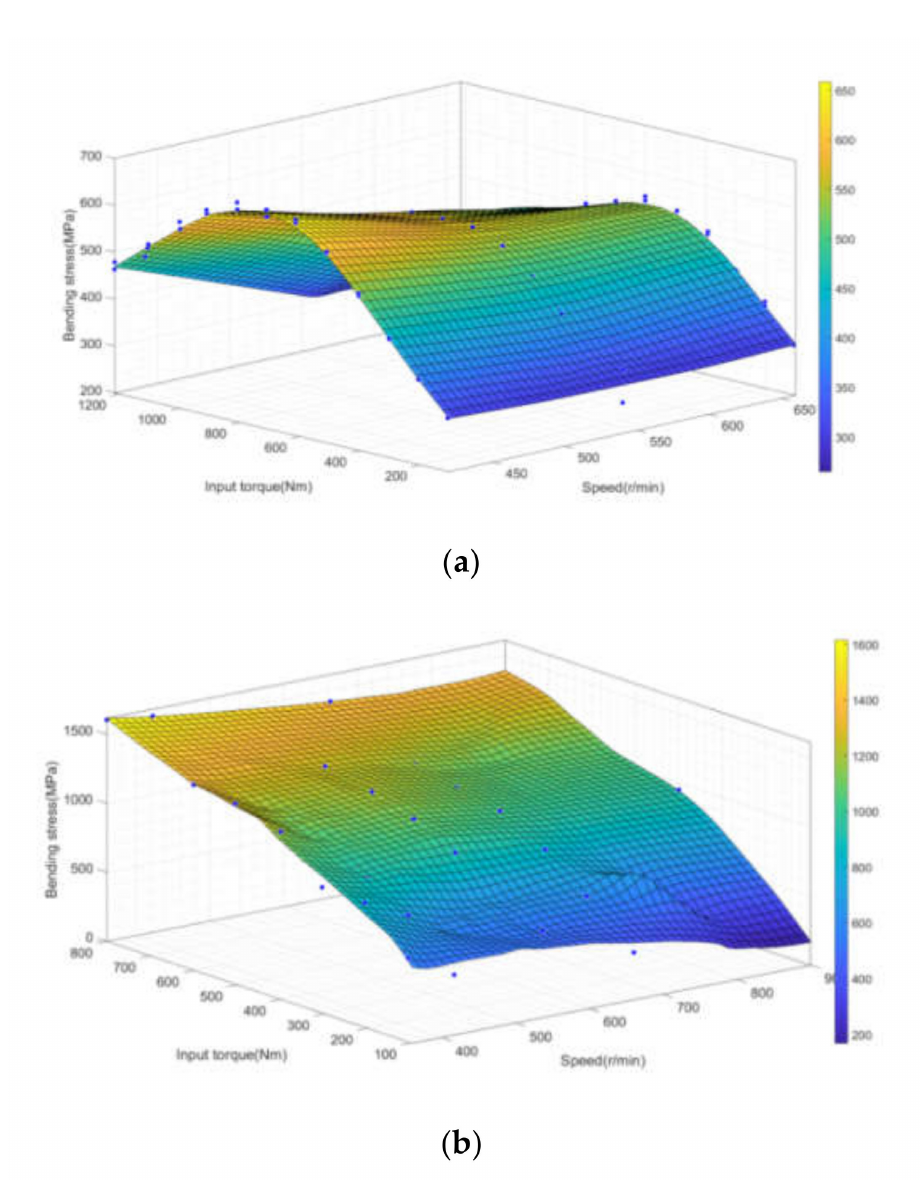
Figure 24. Root bending stress under different rotational speeds and input torque conditions: ( a ) HCR internal spur gear drive; ( b ) involute internal spur gear